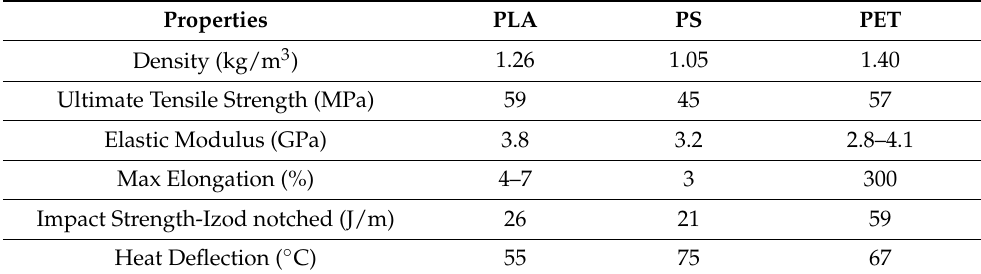
Table 7. Properties of PLA, PS, and PET [15–17,21,23,54,57].